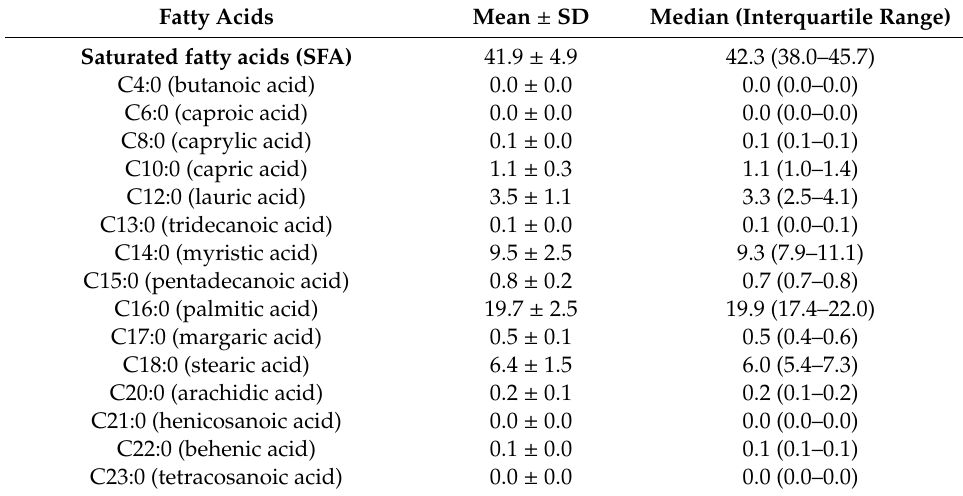
Table 2. Fatty acids composition (%) of human milk 1